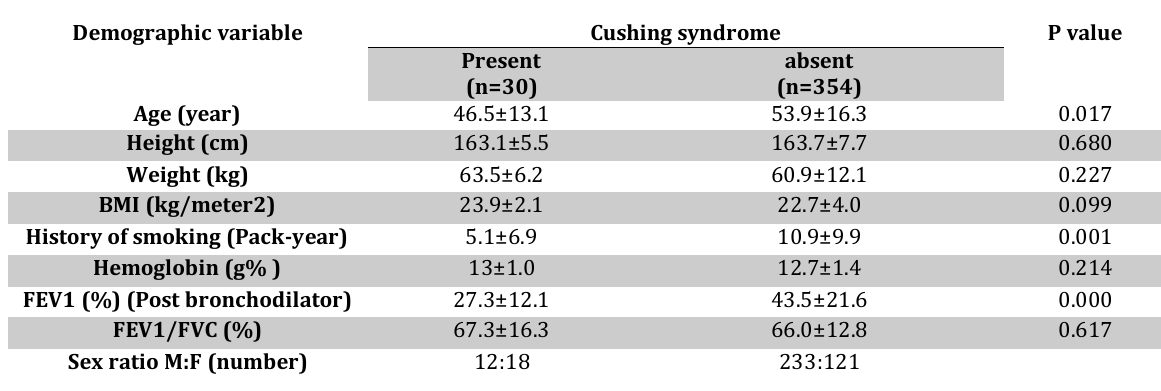
Table-4 . Comparison of demographic data in patients with and without Cushing’s syndrome Demographic